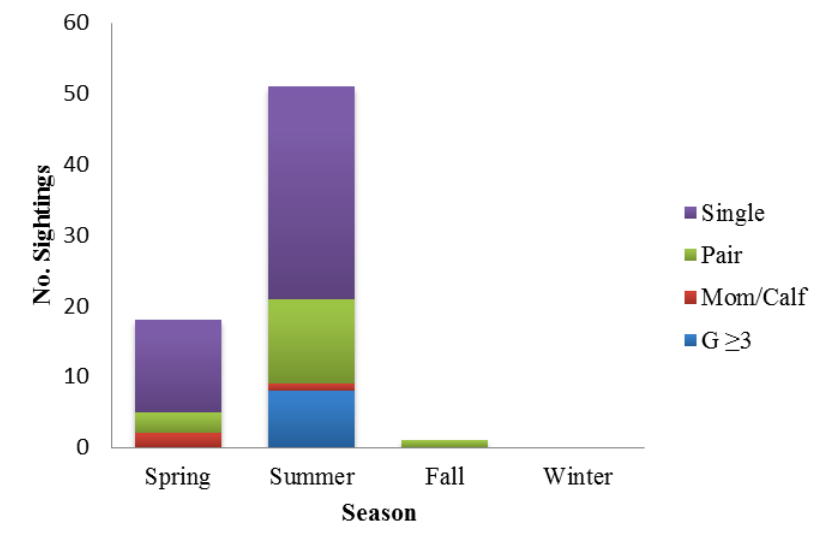
Figure 3. Group type frequency by season.